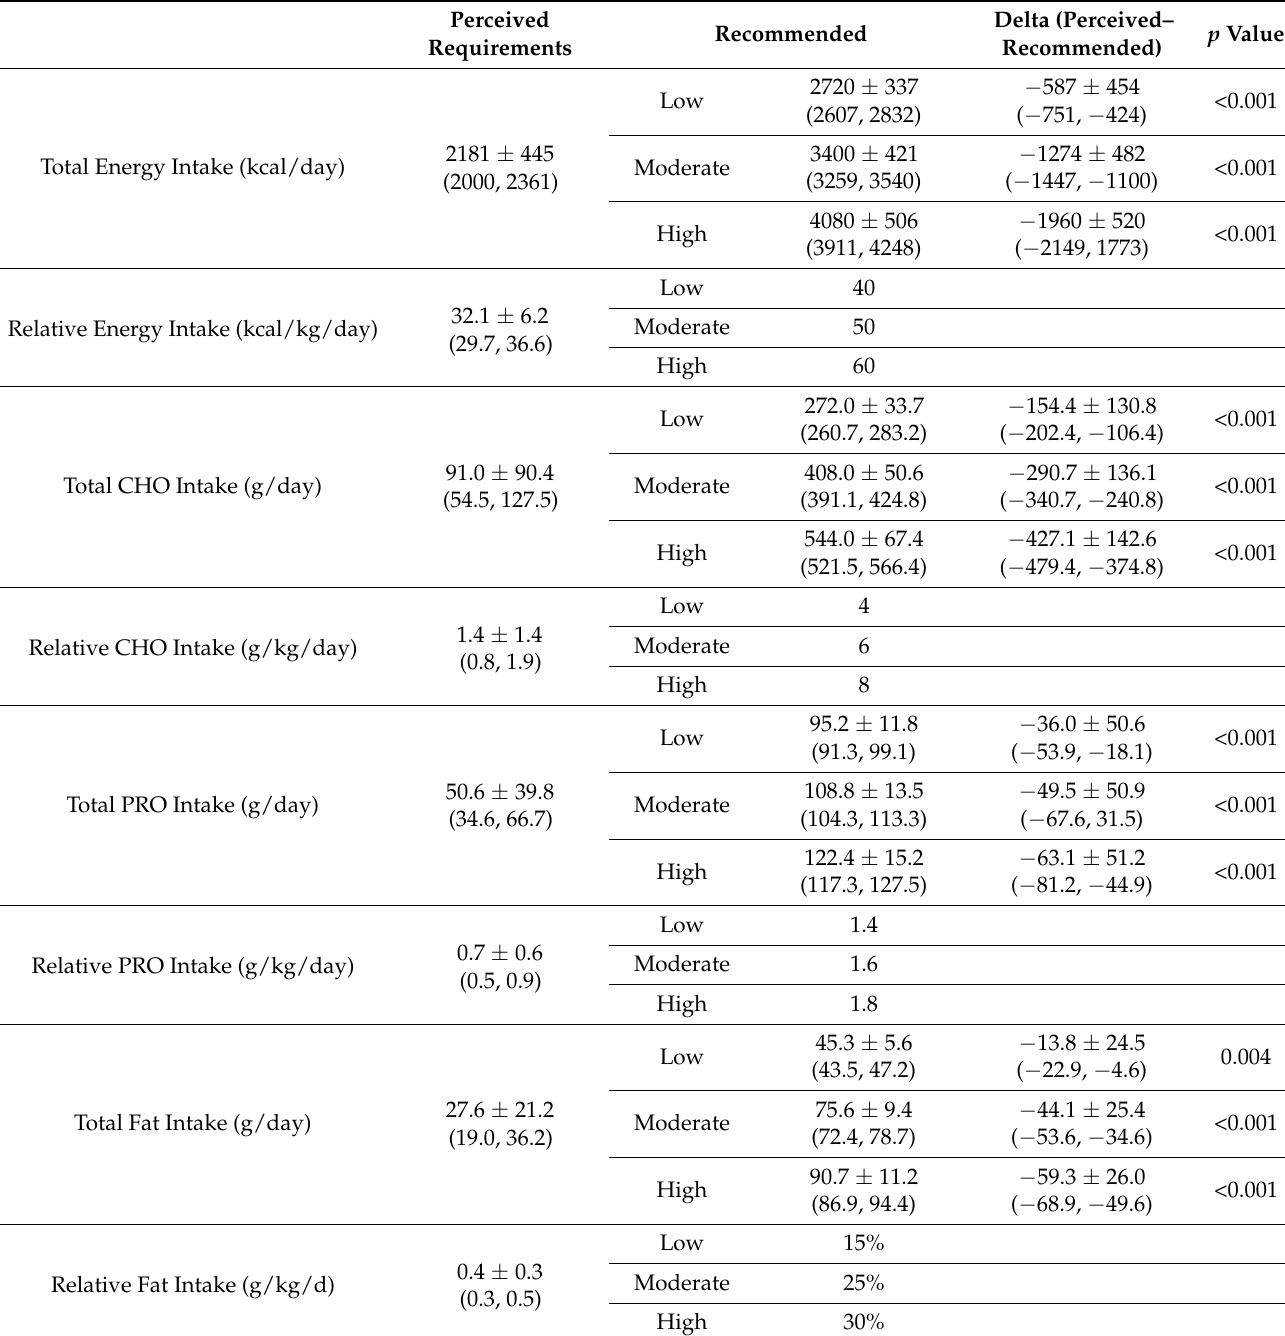
Table 3. Comparison of perceived dietary requirements versus predicted for women athletes. Delta Perceived Recommended Requirements